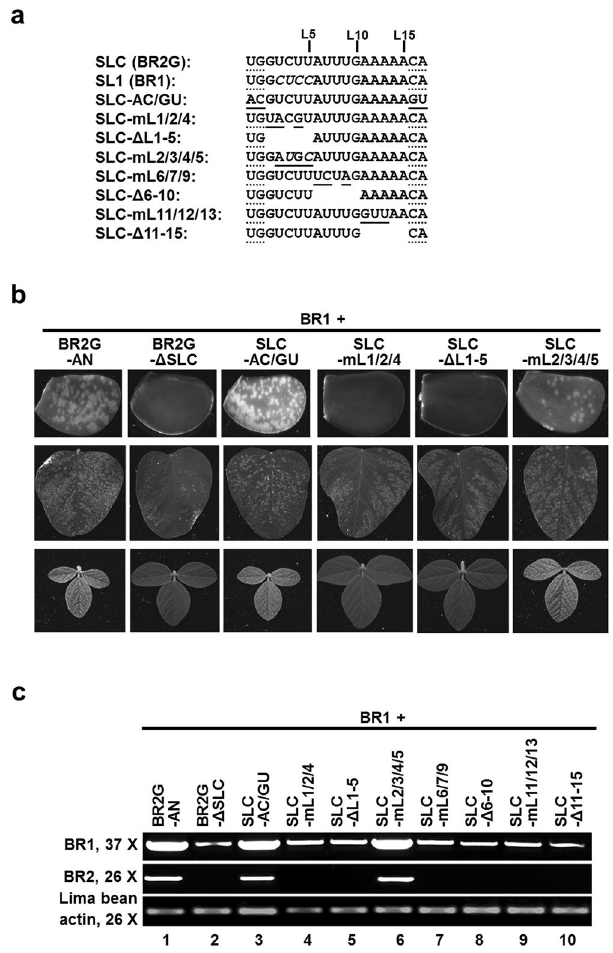
Figure 4. The loop portion of SL1 and SLC is highly conserved. ( a ) The nts within the loop of SLC and SL1 are shown along with the changes introduced in eight loop-specific mutants. The numbers above the nt sequences (L5, L10, L15) mark the positions of the corresponding nts in the loop. The nts at both ends, underlined with dots, make up the two neck base pairs adjacent to the loops. Mutated nts are highlighted with solid underlines, deletions are denoted by spaces. ( b ) The infectivity of a selected set of loop mutants in bombarded lima bean cotyledons (top row), inoculated (middle row) and systemic (bottom row) soybean leaves. ( c ) RT-PCR detection of the BR1 and BR2G viral RNAs in lima bean cotyledons bombarded with the loop